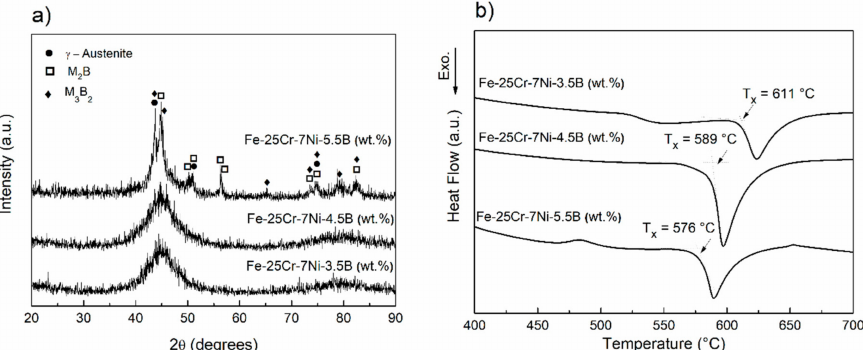
Figure 1. X-ray diffraction (XRD) ( a ) and differential scanning calorimeter (DSC) ( b ) curves of 68-xFe25Cr7NixB (x = 3.5, 4.5, and 5.5 wt.%) as-spun ribbons obtained by